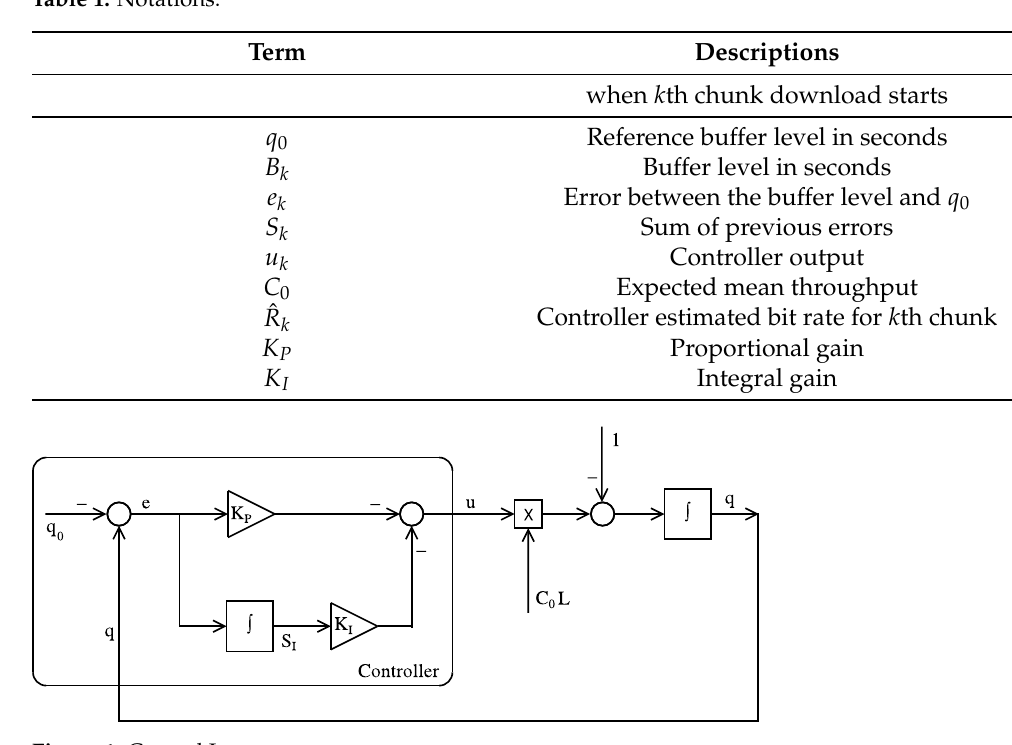
Figure 1. Control